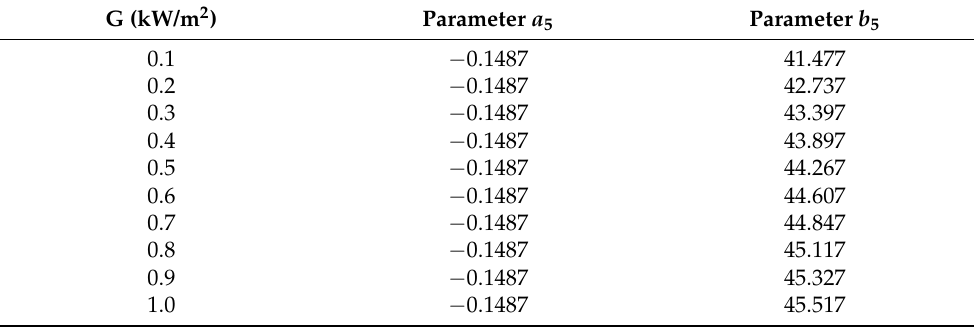
Table 4. Relationship between parameter a 5 , parameter b 5 , and irradiance level G. G (kW/m 2 ) Parameter a 5